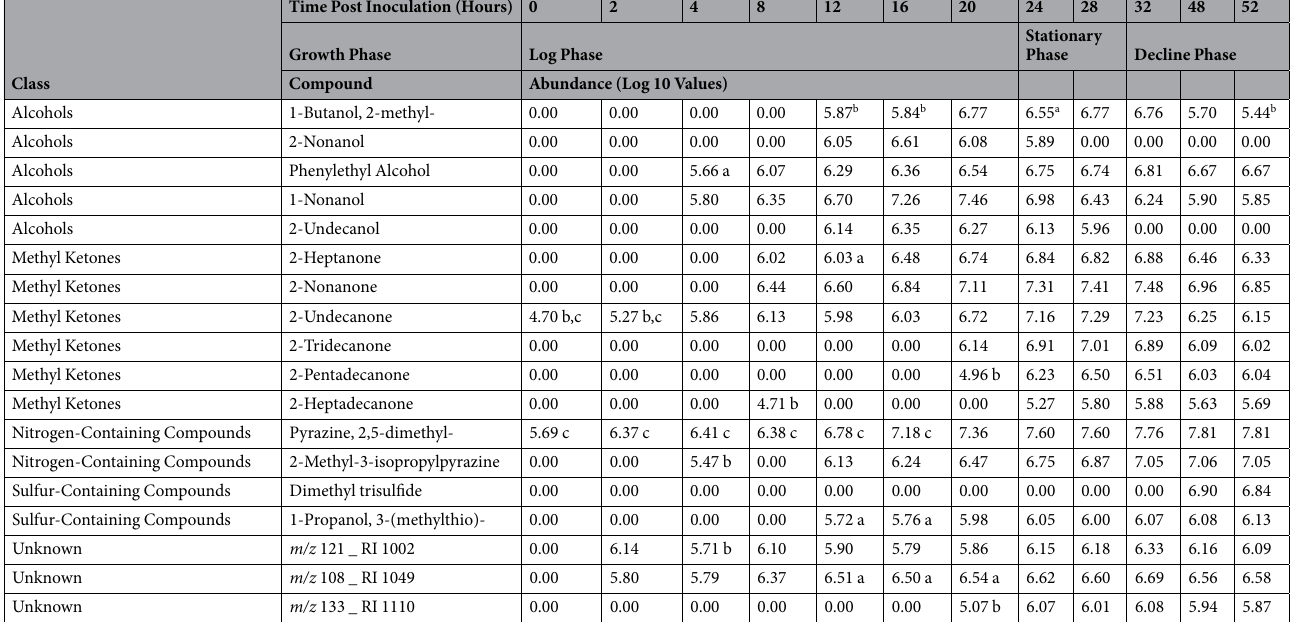
Table 4. Average relative abundances (Log-10 Scale) of F. tularensis novicida -associated VOC markers at all measured timepoints, separated by growth phase. Notes: a VOC detected in 2/3 of triplicate measurements b VOC detected in 1/3 of triplicate measurements c VOC detected at levels less than 10x abundance in media